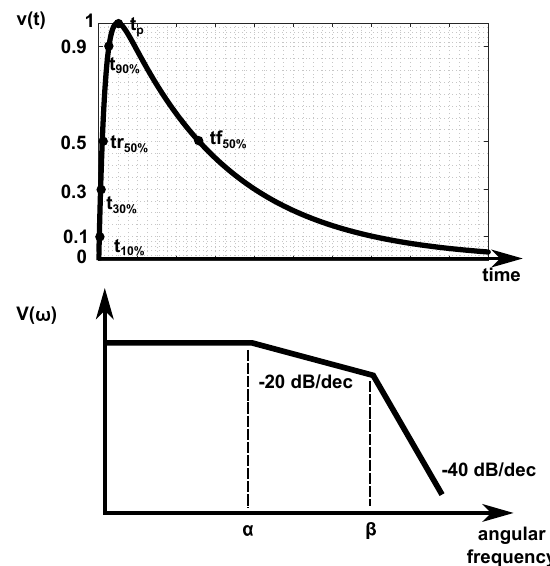
FIGURE 1. Generic double exponential waveform in time (top) and frequency (bottom) domains. It was considered normalized amplitudes for both cases. TABLE 1. Parameters for some Double Exponential Functions in EMC - normalized